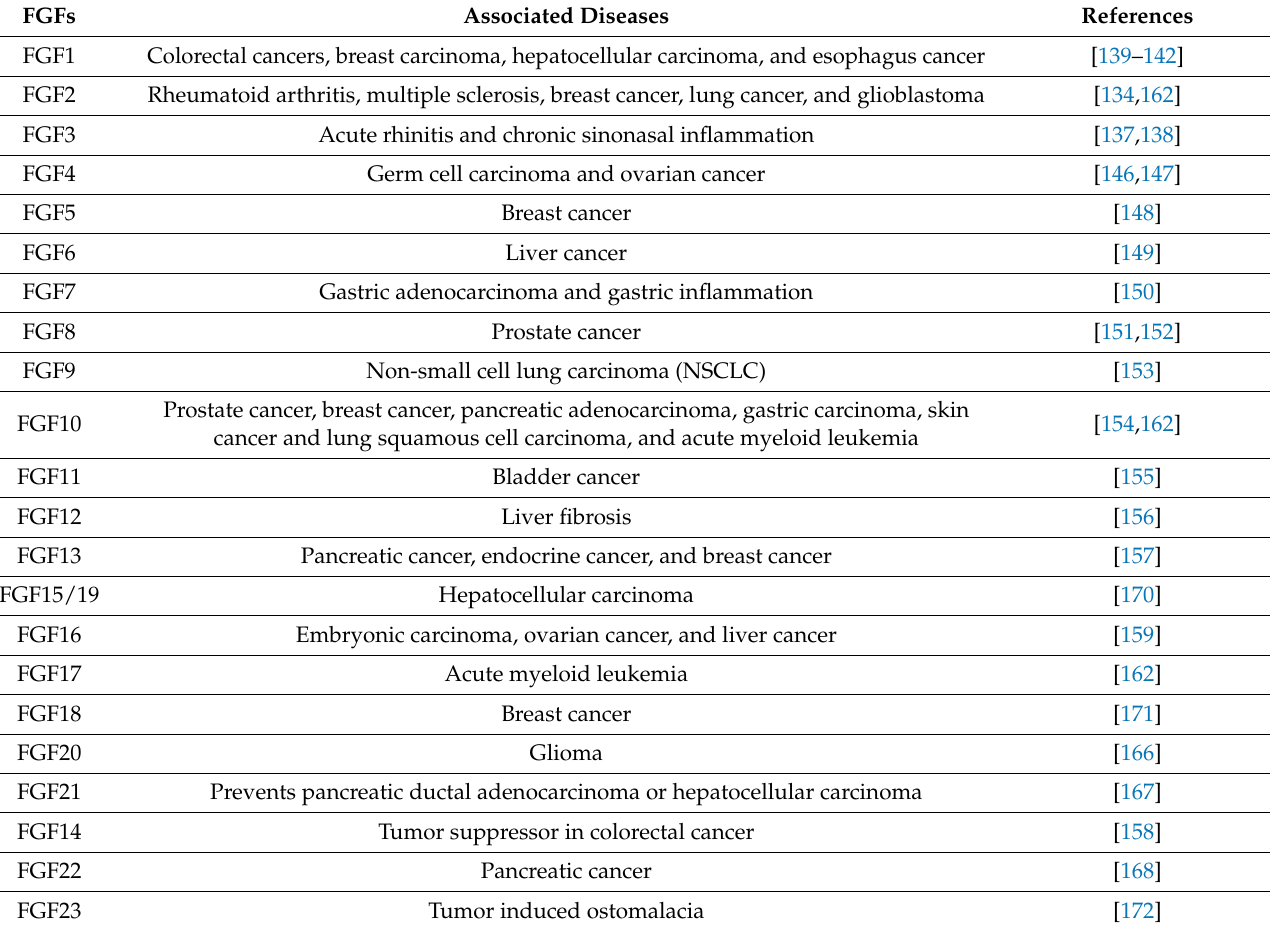
Table 3. FGFs and associated diseases, particularly those associated with